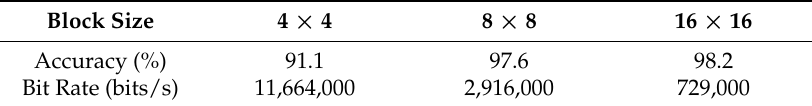
Table 5. Accuracy and Bit Rate comparison.